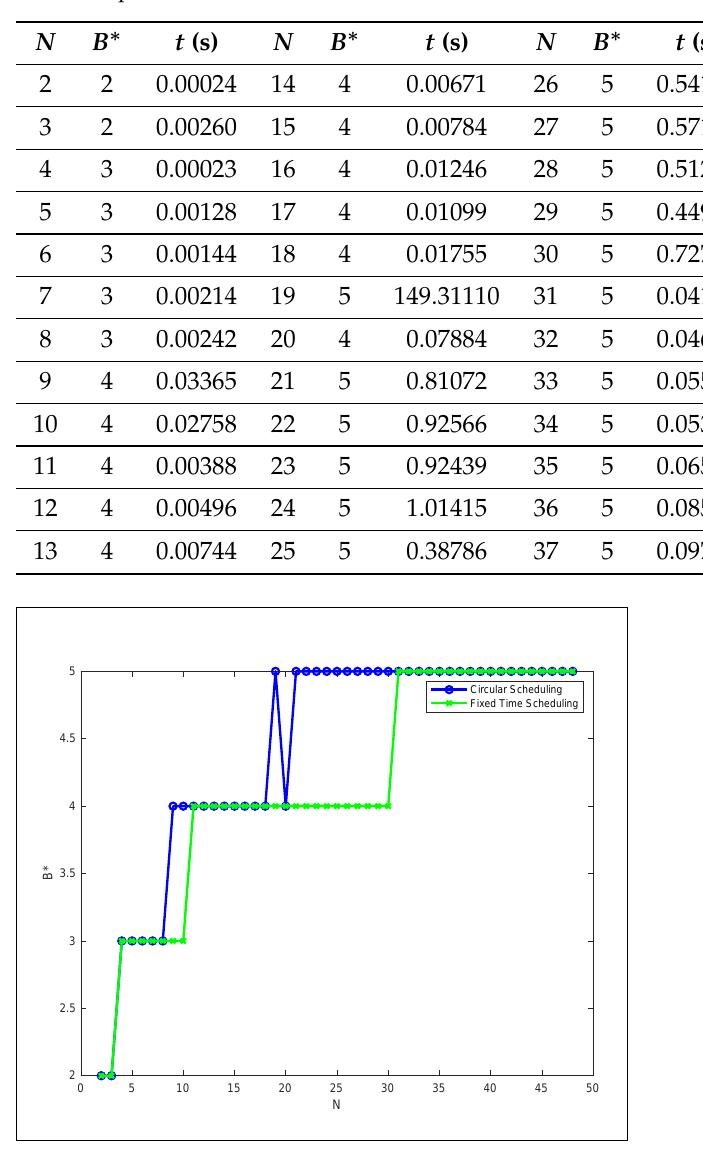
Figure 11. B ∗ as a function of N for circular and fixed time